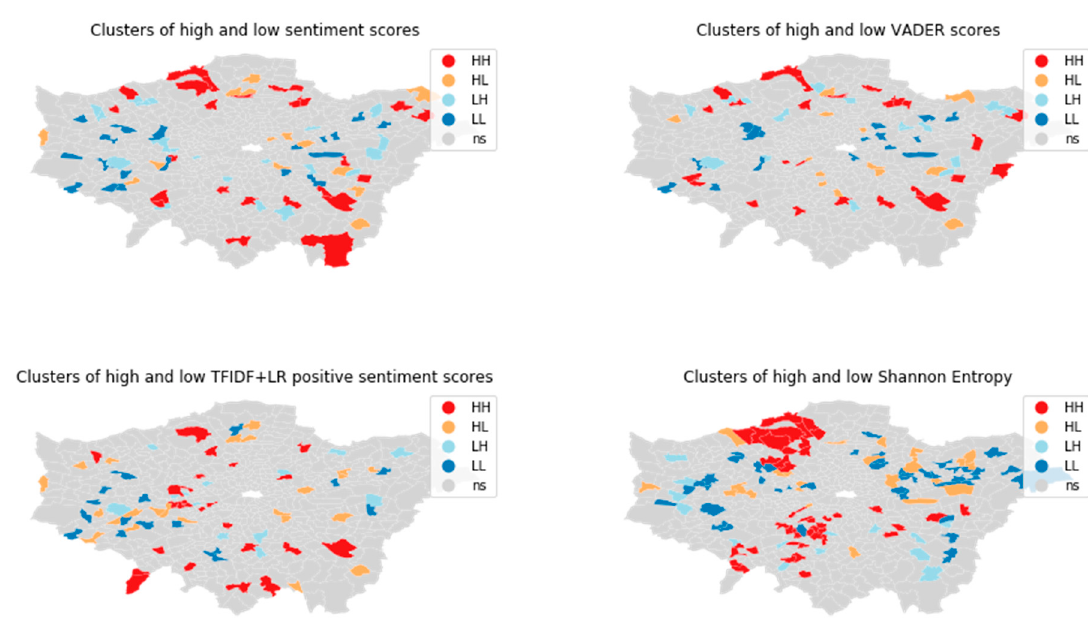
Figure 3. Spatial clusters (local Moran’s I, p < 0.05) of sentiment scores and LOAC diversity .